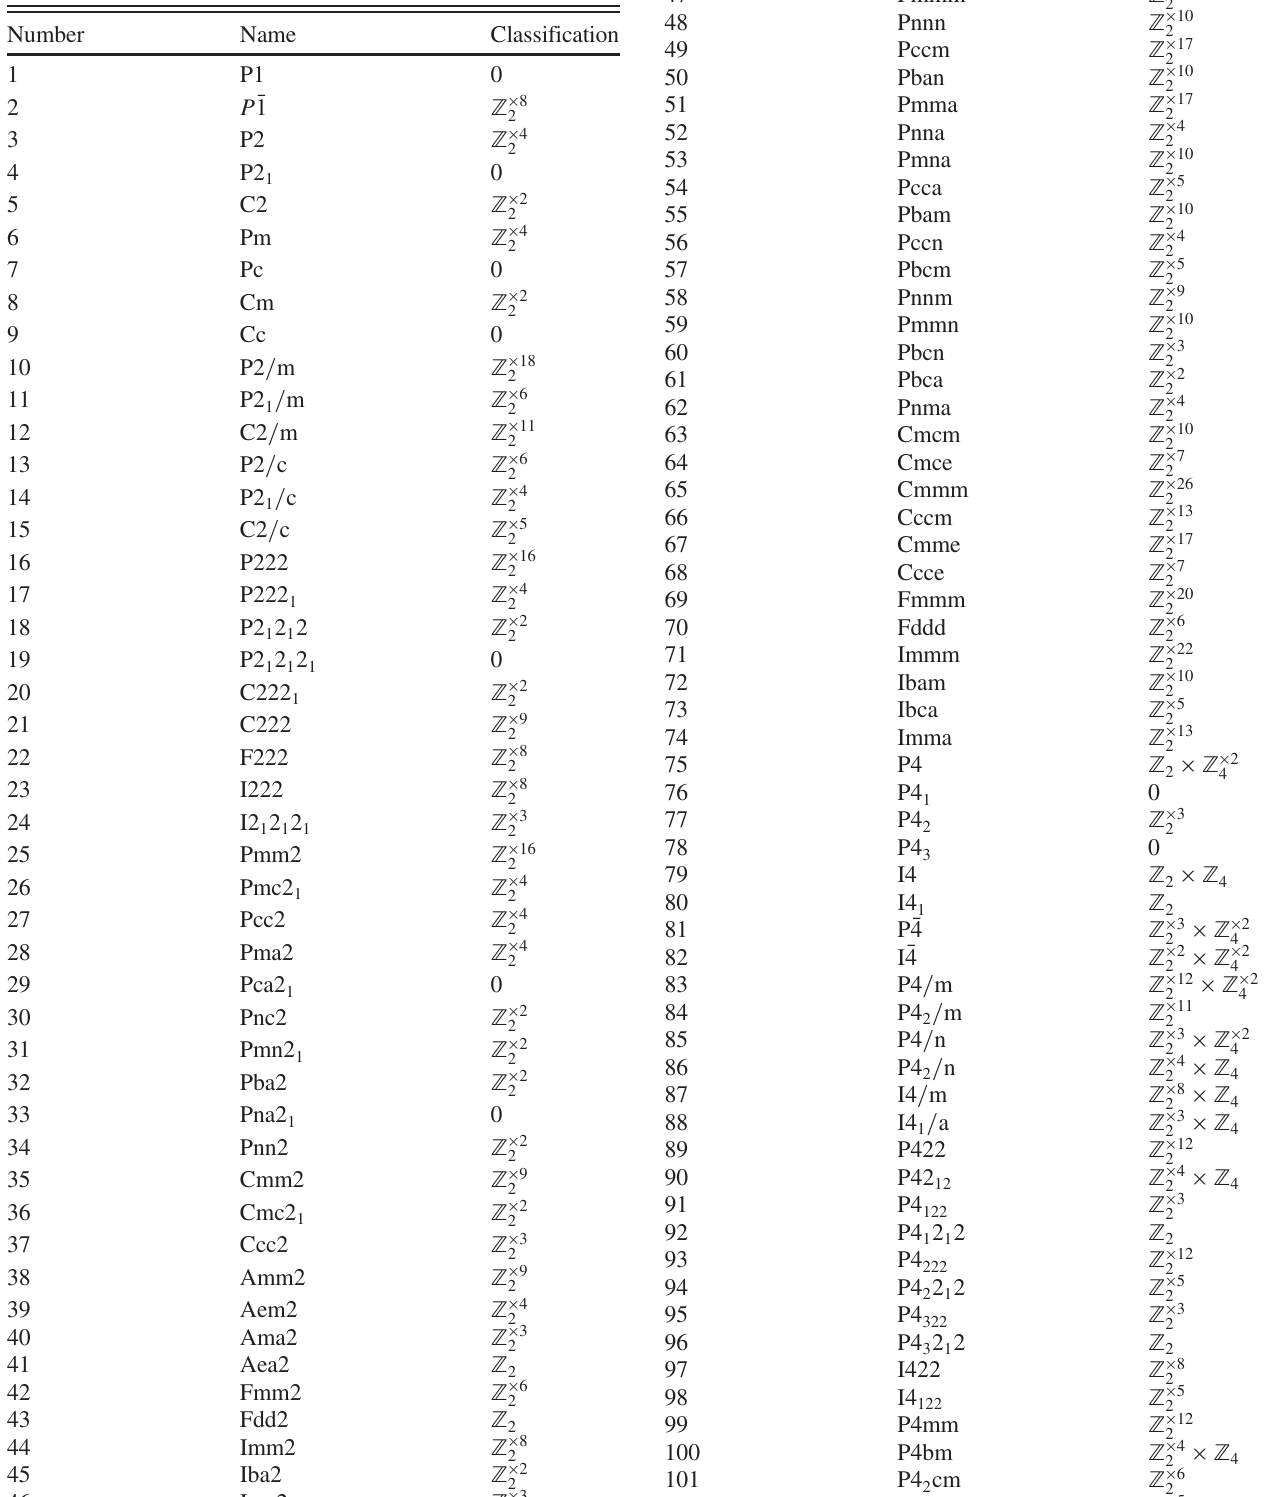
TABLE II. The 230-fold way. This table shows the classifica- tion of bosonic crystalline SPT phases in ð 3 þ 1 Þ D for each of the 3D space groups. For space groups 227, 228, and 230, the classification has not been